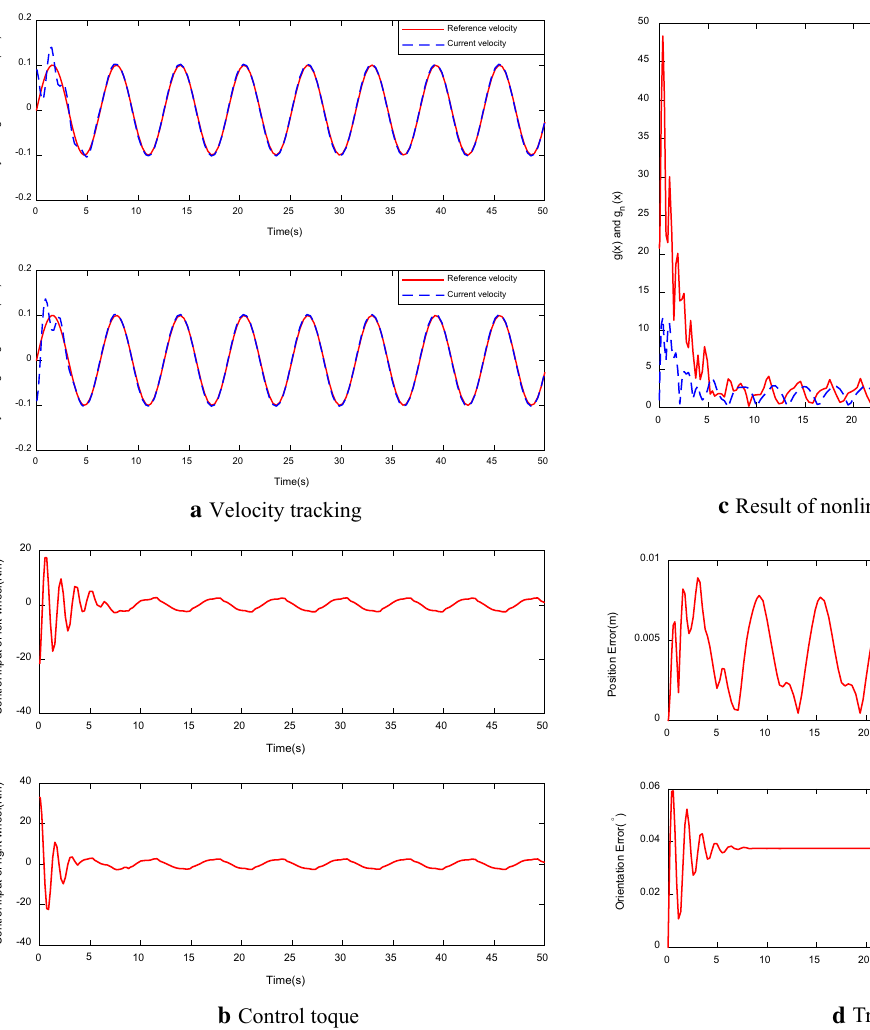
Figure 3 Simulation results